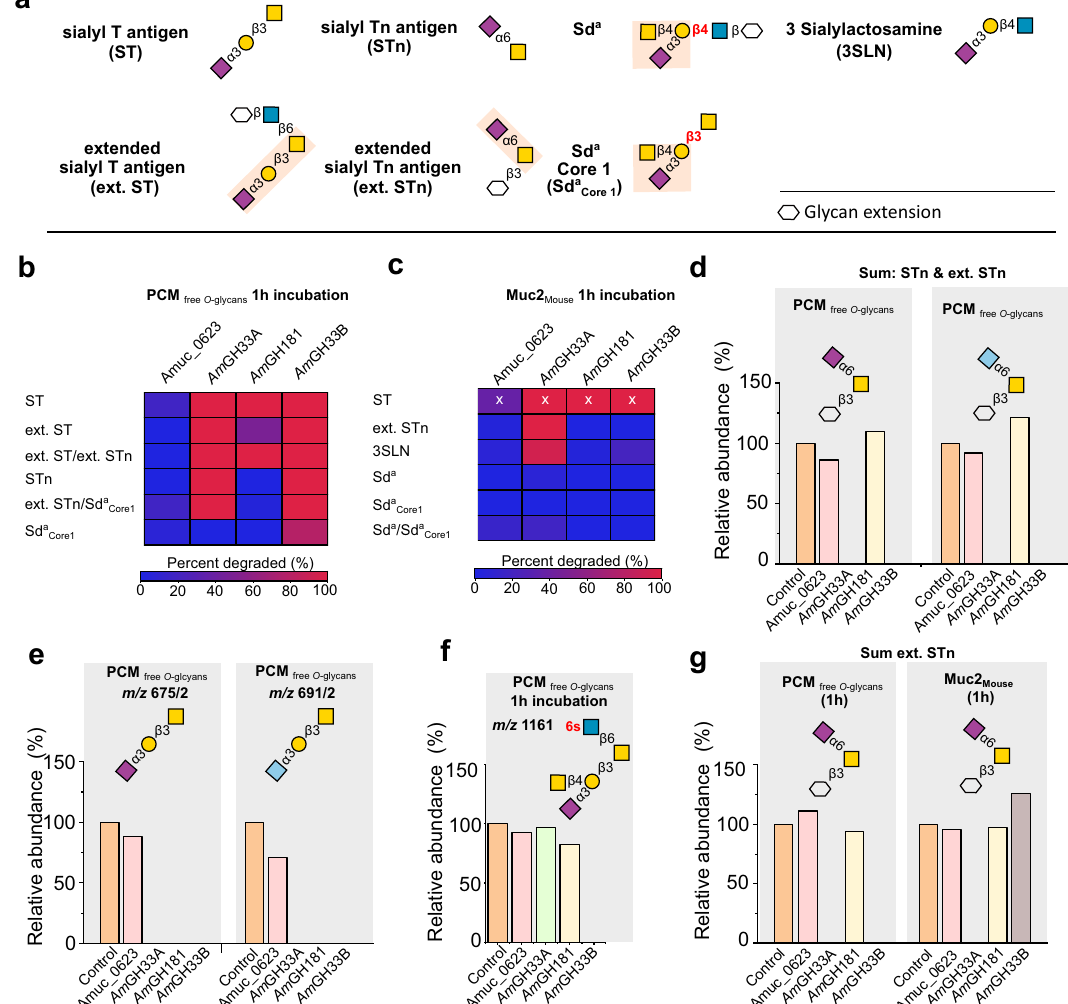
Fig. 2 | The activitypro fi les of A. muciniphila sialidases.a Overviewof sialylated (denoted with “ S ” ) epitopes, in the analyzed mucin and released mucin O -glycans. b , c Activity heat maps on sialylated epitopes in released porcine colonic mucin O -glycans (PCM free O -glcyans ) and mouse MUC2 attached O -glycans (MUC2 Mouse ), respectively after 1h incubation. d , e Examples showing the broad substrate recognitionof Am GH33Aand Am GH33B towards α 2,3- and α 2,6-linkedthe Neu5Ac and Neu5Gc (light blue) sialic acid forms. f An example illustrating speci fi - city differences between the investigated sialidases. g A comparison of activity pro fi lesonthesumofsialylatedextendedTnepitopeseitherinPCM free O -glcyans and MUC2 Mouse . The enzymatic reactions were performed with PCM free O -glcyans or